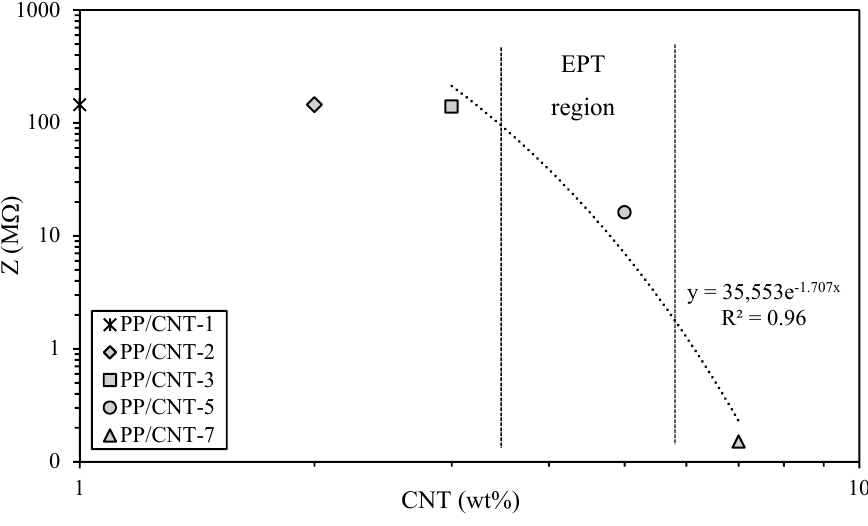
y = 35,553e -1.707x R² = 0.96